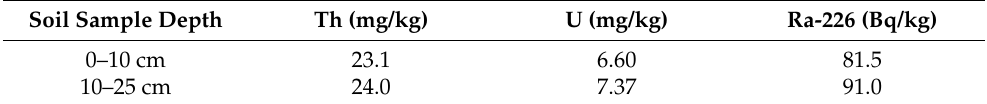
Table 3. Uranium and Thorium soil content profile according to FOREGS data. Soil Sample